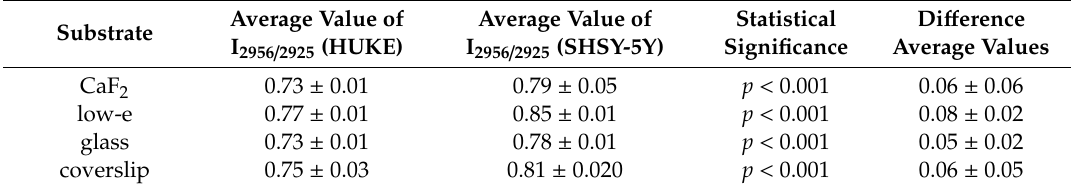
Figure 3. Average and standard deviation values of the ratio I 2956 / 2924 between the intensity of the peak at 2956 cm − 1 and the intensity of the peak at 2924 cm − 1 for HUKE (red circles) and SH-SY5Y (black circles) cells grown on CaF 2 ( a ), low-e ( b ), glass ( c ), and coverslip ( d ) substrates. Table 2. Average values of I 2956 / 2924 for HUKE (second column) and SH-SY5Y (third column) cells grown on di ff erent substrates (first column). Statistical significance of separation of I 2956 / 2924 values for the two types of cells is reported in the fourth column, whereas the fifth column shows the di ff erence of average I 2956 / 2924 values.